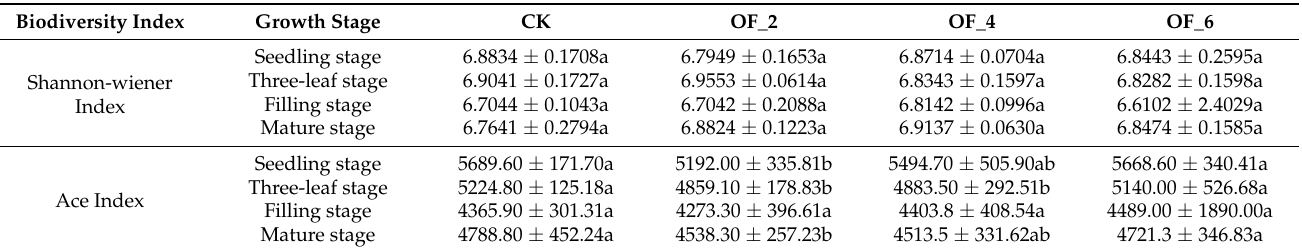
Table 3. Shannon index and Ace index of soil